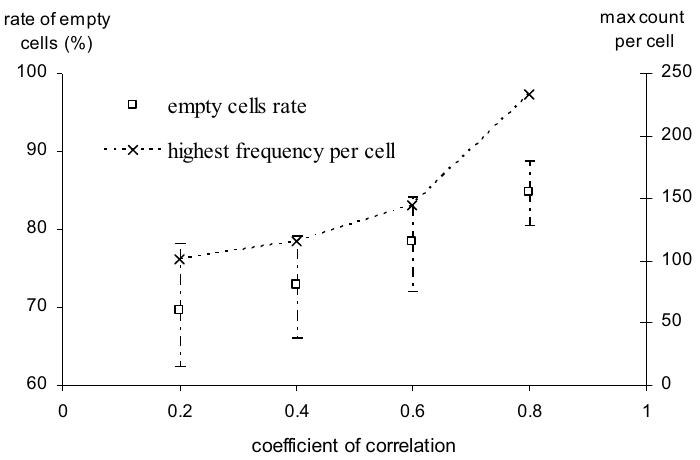
Figure 1 – Average rate of empty cell (%) (horizontal bars represent the maximum and the minimum rate) and average highest cell frequency across 100 simulated tables versus the correlation coeffi-